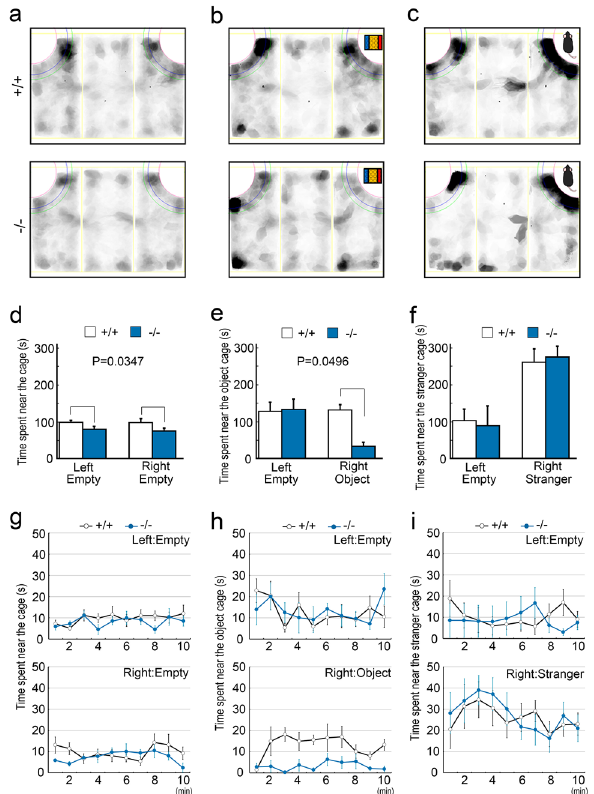
Figure 7. The reduced approach of the Pcdh9 KO mice to a novel object. ( a – c ) Schematic diagrams of the three- chamber cages. The mouse behaviours were traced with shadows in each experiment. ( a ) Mice were habituated in the case with two empty chambers at the corners for 10 min before experiments. ( d – f ) Statistics (Two-way ANOVA) of the results in each experiment. ( d ) During habituation, the Pcdh9 KO mice showed a